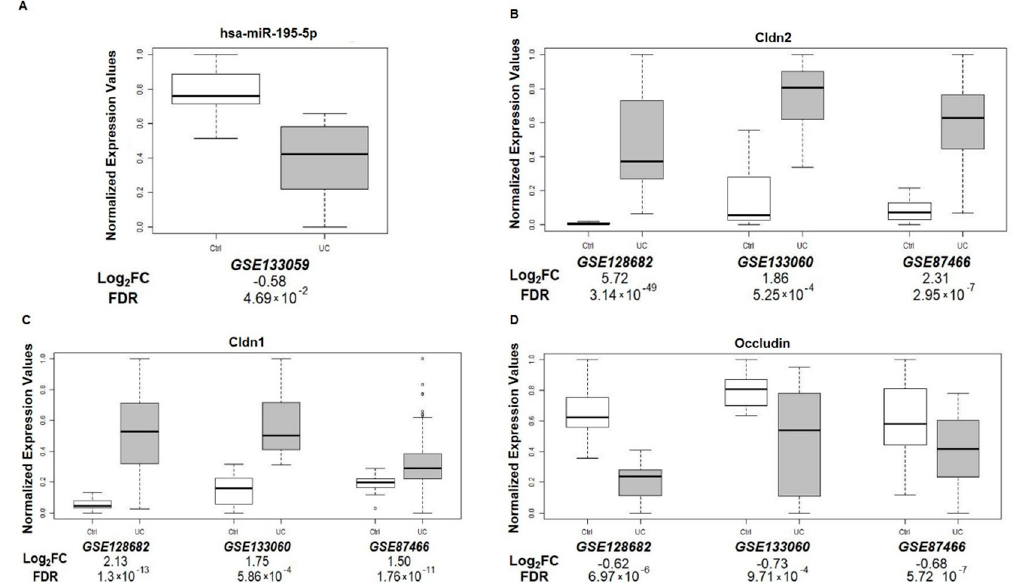
Figure 7. miR-195-5p, Cldn2, Cldn1, and Occludin expression in UC patients. Analysis of colonic tissue from UC and controls downloaded from the GEO database (GSE133059, GSE133060, GSE128682, and GSE87466). Mean expression data of miR-195-5p (A), Cldn2 (B), Cldn1 (C), and Occludin (D) were expressed as normalized expression values. LogFC value and FDR were reported for each dataset and each signal.